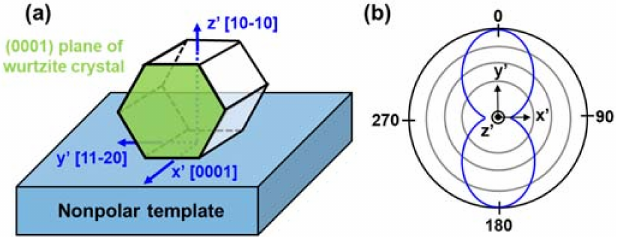
Figure 12. ( a ) Illustration of x’, y’ and z’ orientation in non-polar epitaxy system as an example. ( b ) Schematic illustration of polarization of non-polar VCSELs when I > I th